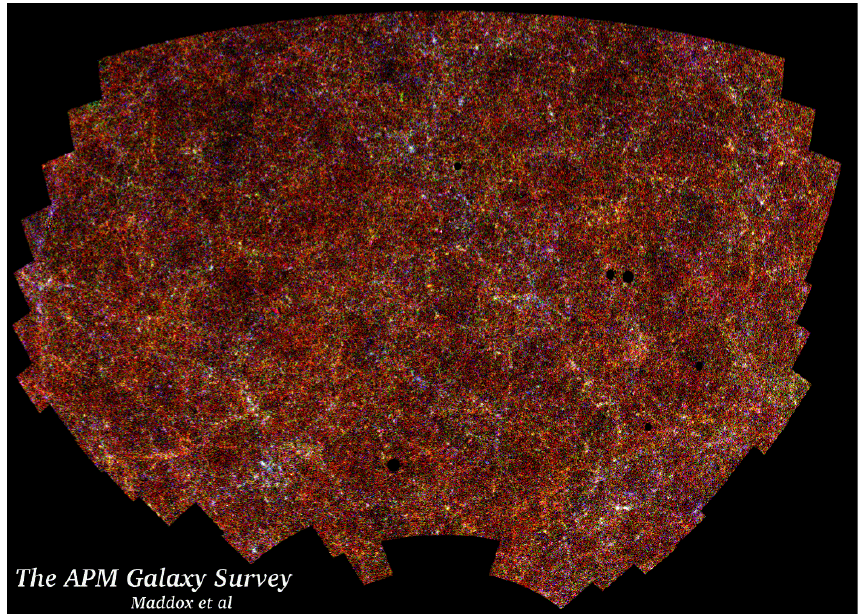
Figure 3. This is a map of the APM Galaxy Survey, containing the positions, magnitudes, sizes and shapes of some three million galaxies. They were selected from 269 UKST survey plates, scanned using the APM Facility. The galaxies have apparent magnitudes with 17 < b j < 20.5 and are spread through the largest volume of the universe that had been surveyed to the date of the map. The picture shows the galaxy distribution as a density map in equal area projection on the sky, centered on the South Galactic pole. Each pixel covers a small patch of sky 0.1 degrees on a side, and is shaded according to the number of galaxies within the area: where there are more galaxies, the pixels are brighter. Galaxy clusters, containing hundreds of galaxies closely packed together, are seen as small bright patches. The larger elongated bright areas are superclusters and filaments. These surround darker voids where there are fewer galaxies. The colors are coded according to the apparent magnitude of the galaxies in each pixel: fainter galaxies are shown as red, intermediate are shown as green and bright ones are shown as blue. Acknowledgment to Steve Maddox, Will Sutherland, George Efstathiou and Jon Loveday,